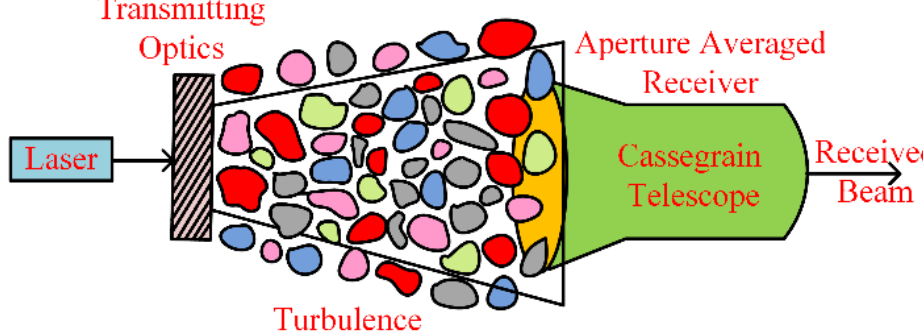
Figure 5. Aperture-averaged FSO communication receiver.